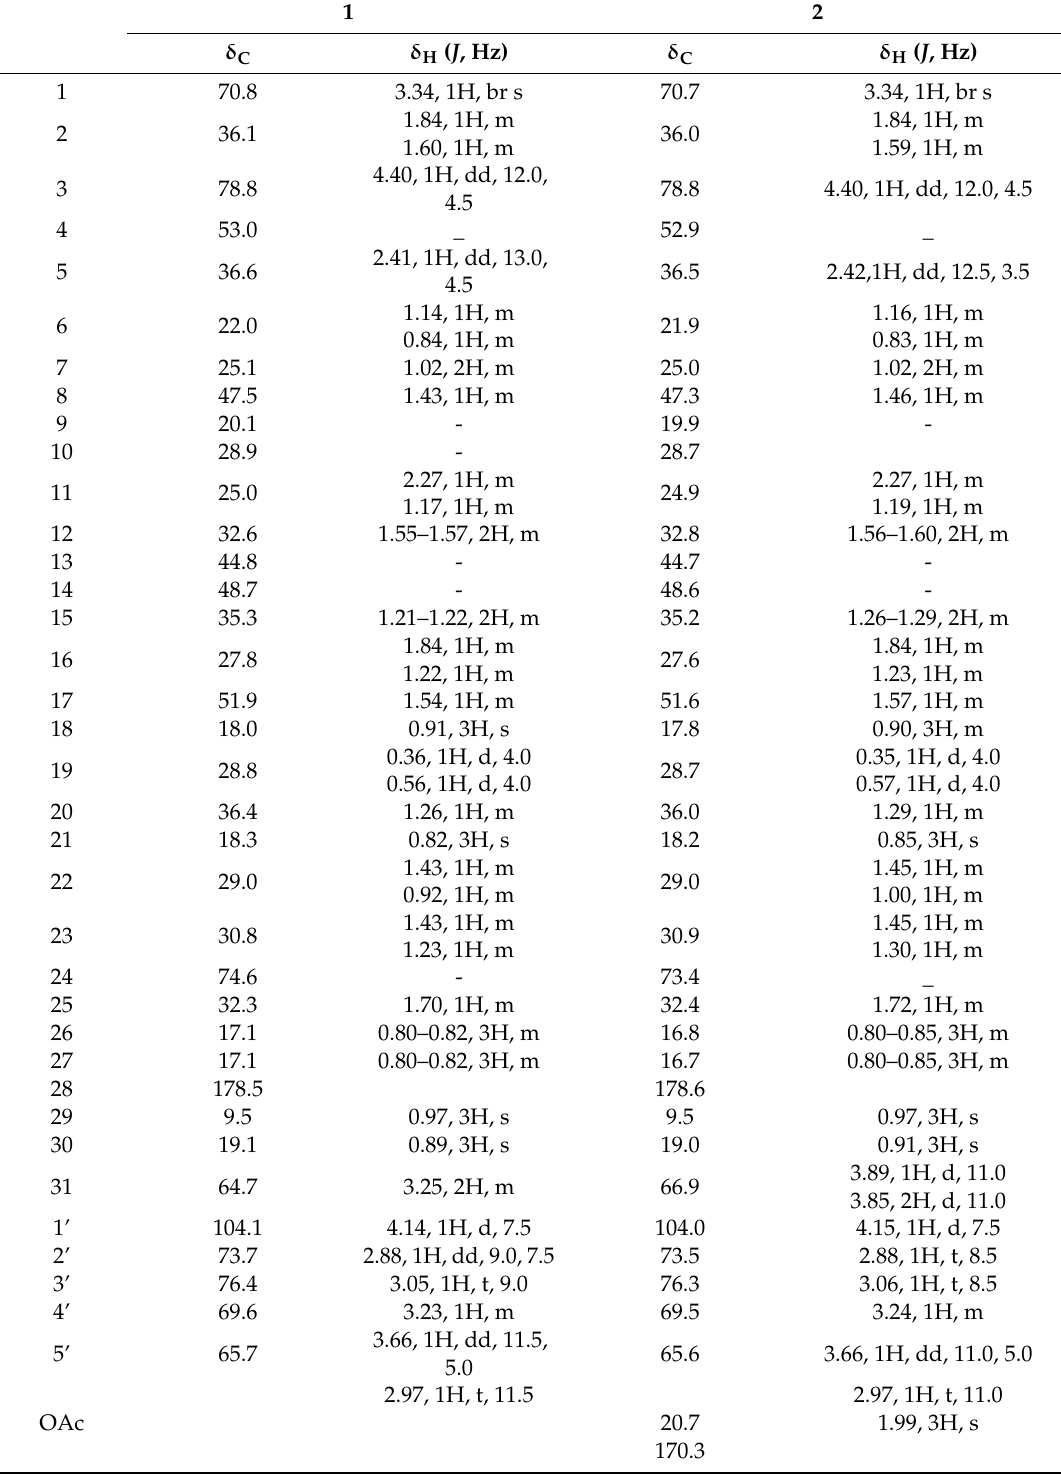
Table 1. 13 C and 1 H NMR spectroscopic data (125 / 500 MHz) for 1 – 2 in dimethyl sulfoxide (DMSO)-d 6 ( δ in